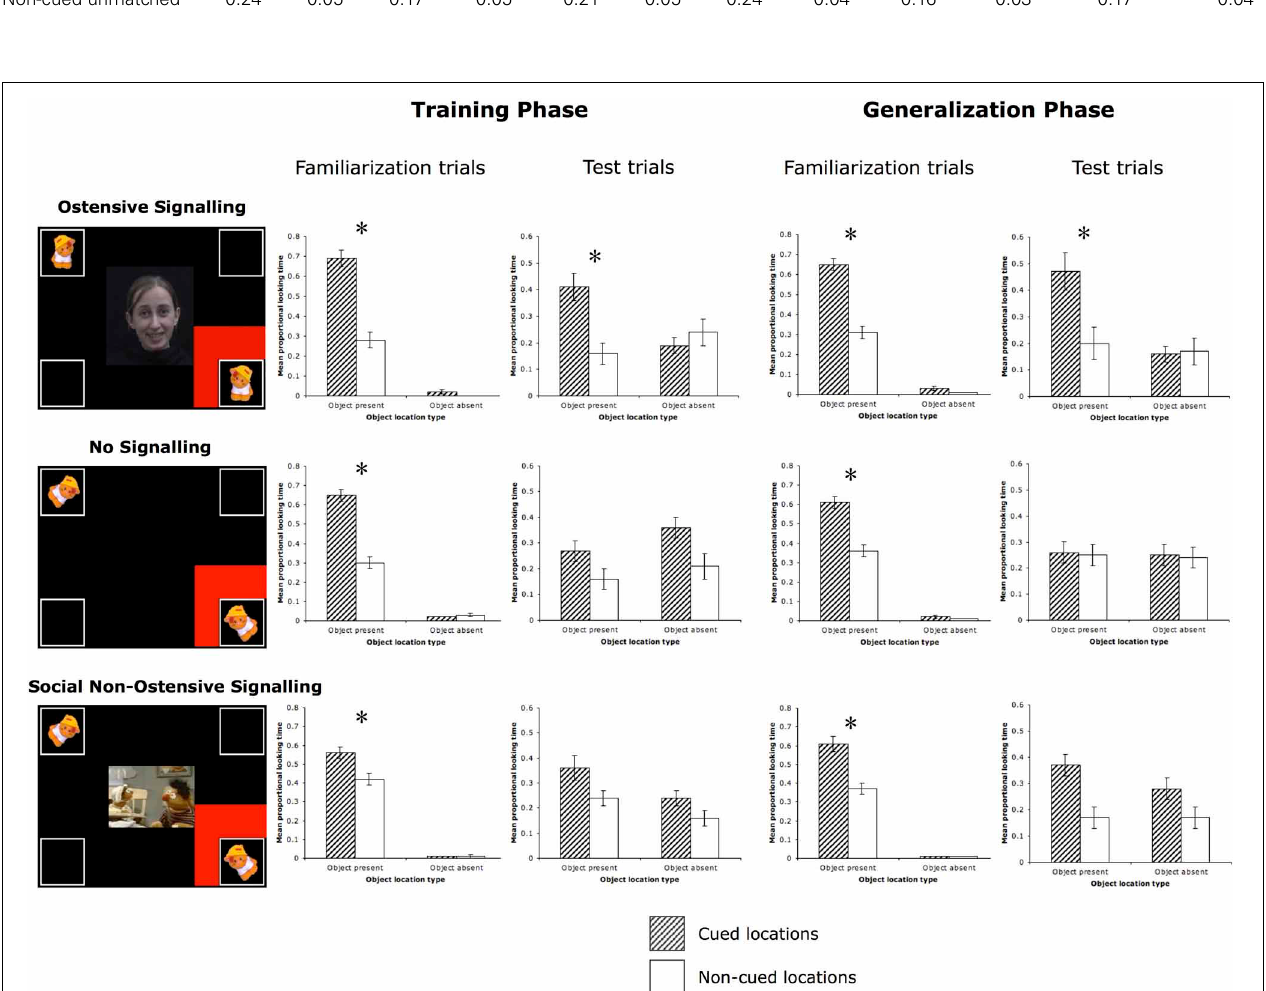
FIGURE 3 | Familiarization and test trials for all three conditions. All stimuli were in full color on a black background. The bar graphs display the results from the familiarization and test trials. ∗ p < 0 . 03.